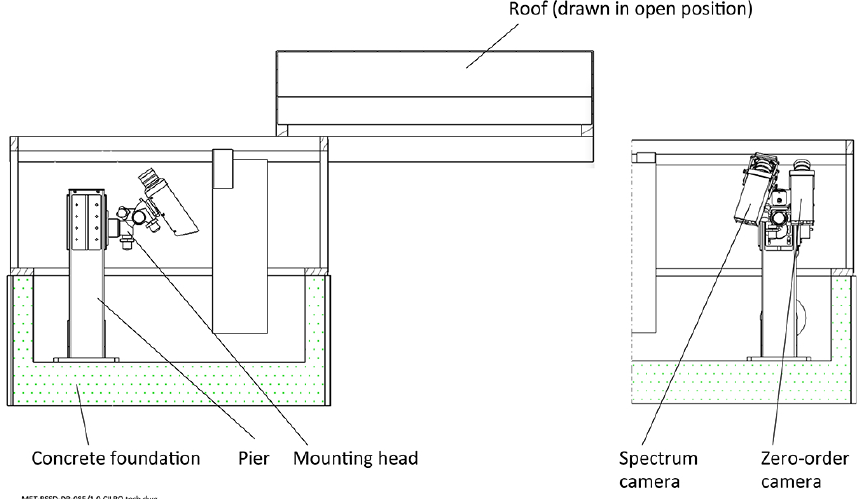
Fig. 5. Cut side view and back view of the complete housing with pier.